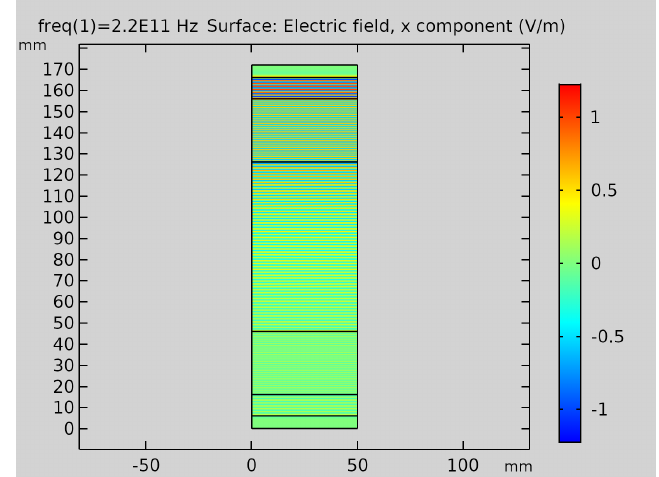
Figure 6. Electric distribution at 220 GHz of n e = 7.3 × 10 18 m − 3 and f e = 1.0 × 10 10 Hz.